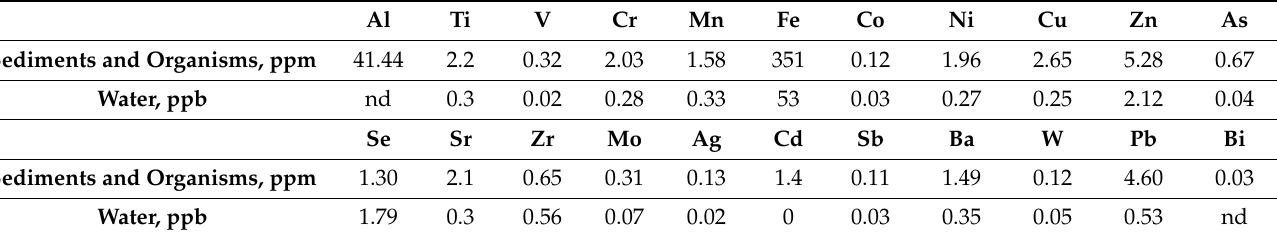
Table 2. Detection limits for the elements in the bottom organisms, sediments, and water of the biotope. Al Ti V Cr Mn Fe Co Ni Cu Zn As Sediments and Organisms, ppm 41.44 nd Sr Bi